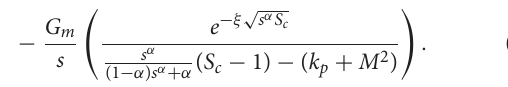
0.5, G r 2, P reff 0.1, G m 0.75, k p 1.5, and S c = = = = =